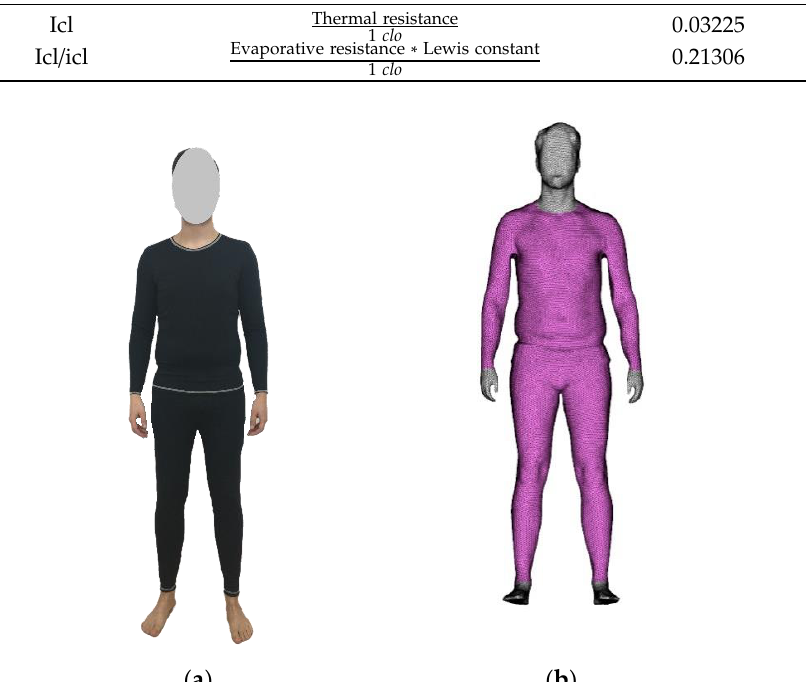
Figure 5. ( a ) Closed-fitted clothing worn by test person, ( b ) the colored area of the virtual model shows where the clothing layer is defined.